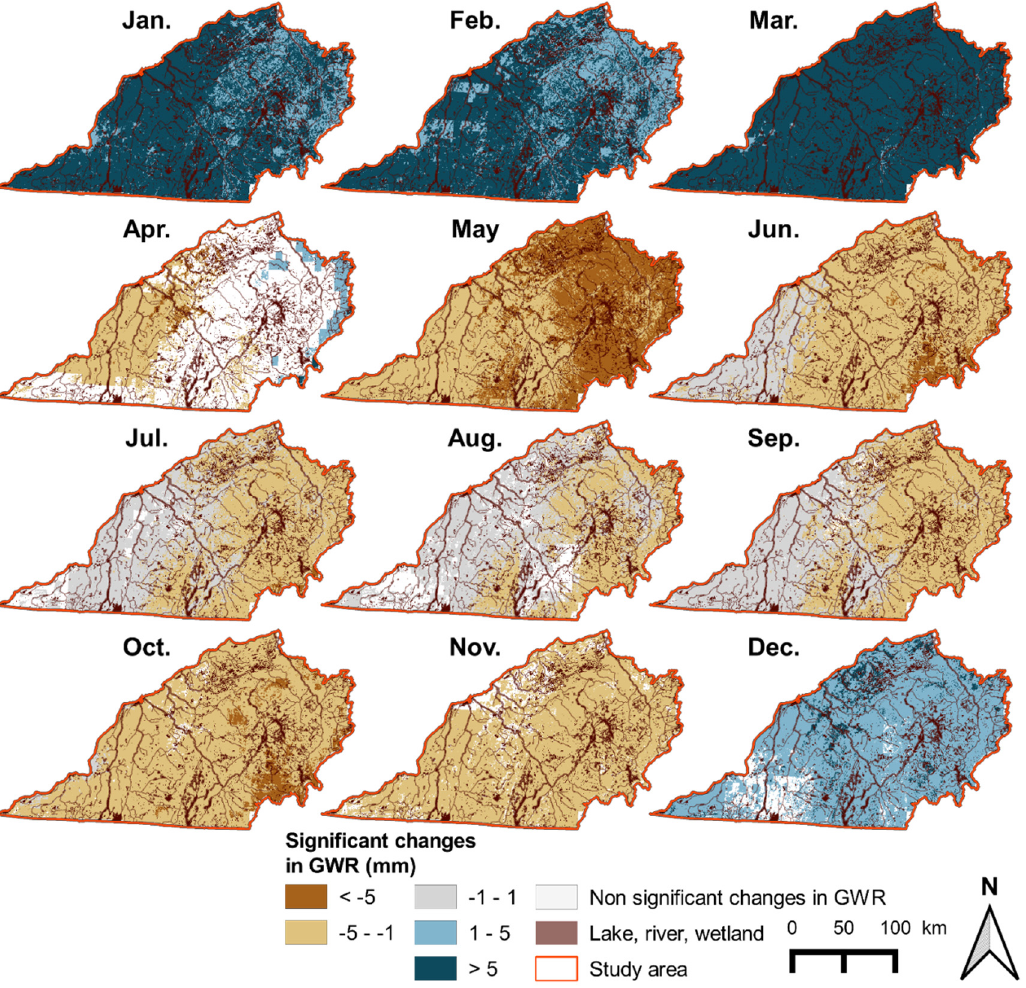
Figure 6. Spatial changes in average monthly groundwater recharge (GWR) between the reference period (1981 − 2010) and the 2041 − 2070 period for the 12 climate scenarios.